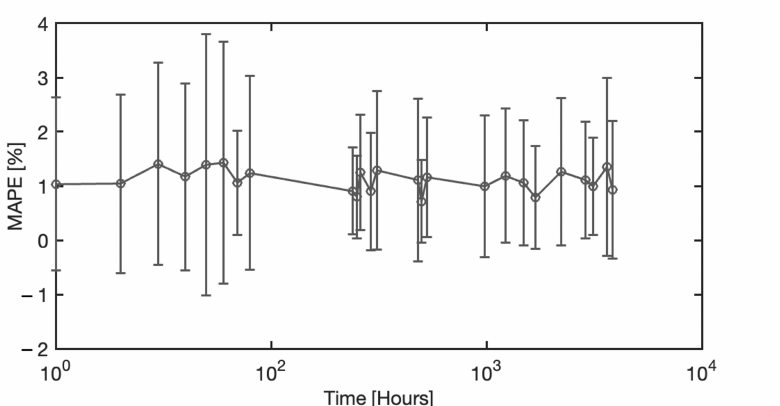
Figure 17. MAPE as a function of the acquisition time, i.e., the age of the blood